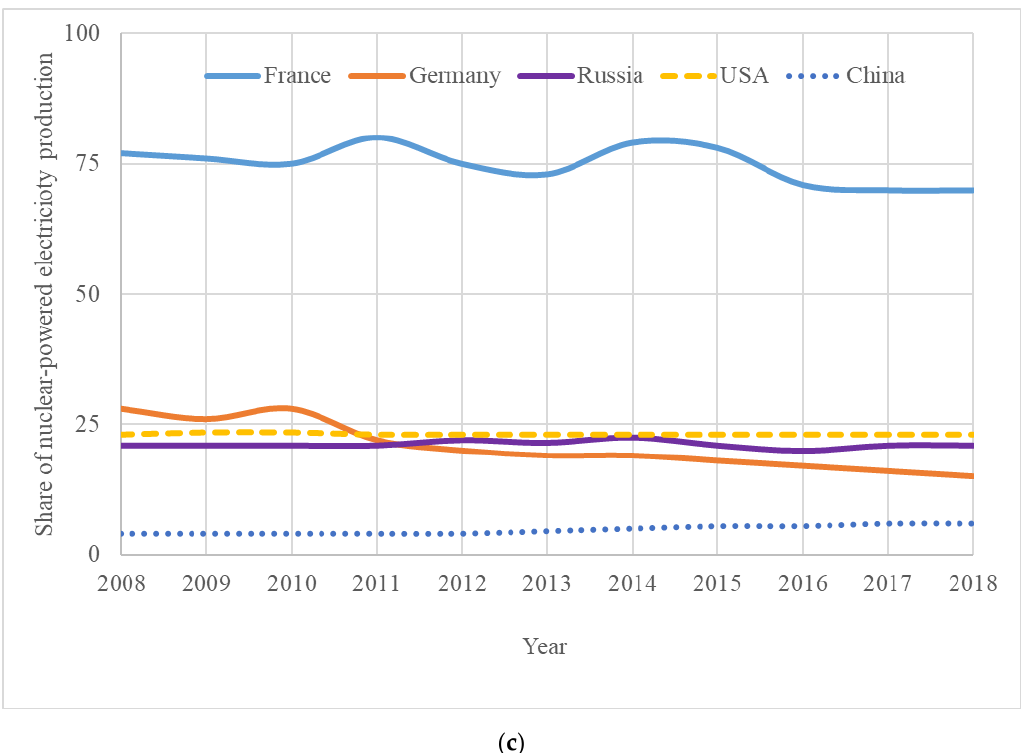
Figure 1. ( a ) Share of global electricity production [1]; ( b ) Member States progress towards their 2013/2014 and 2015/2016 indicative red targets versus RES 2020 target. National renewable energy action plan, data from member states (NREAP), RES. Source: [3]; ( c ) Share of nuclear-powered electricity production [4].